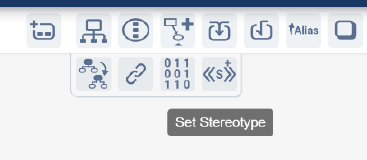
Figure 6. The Set Stereotype button in OPCloud secondary toolbar.